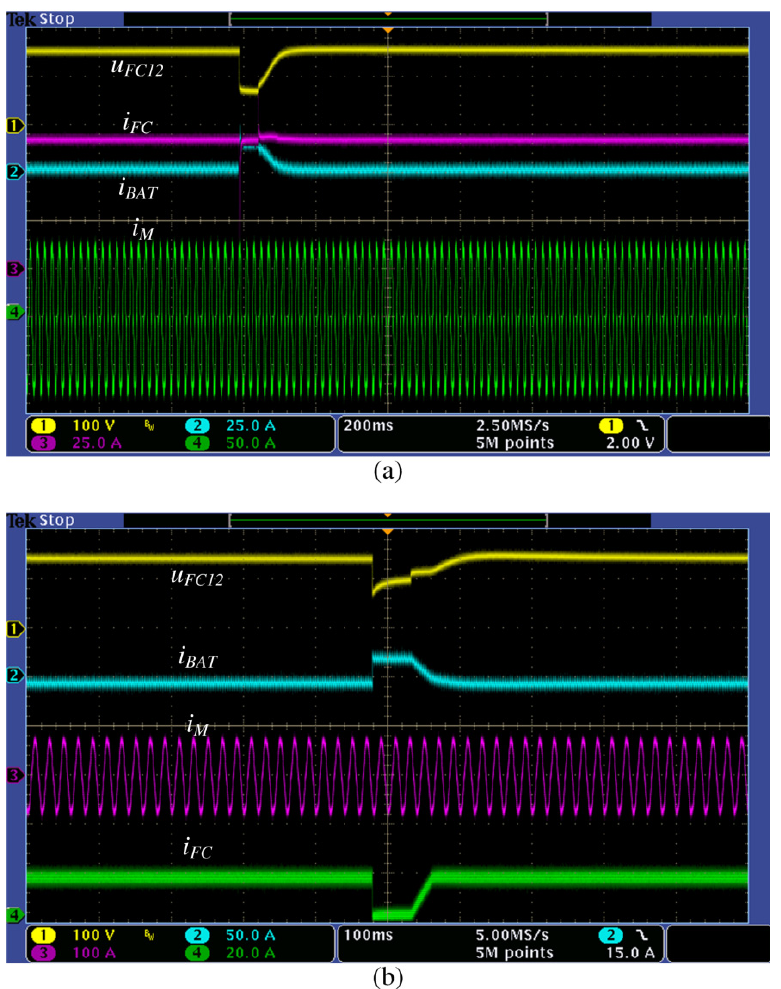
Figure 8. Possible behavior of the DC/DC converter during fuel cell short-circuit, ( a ) with loading and ( b ) with unloading, u FC12 –fuel cell total voltage, i FC –fuel cell current, i BAT –battery current, ( b ) with unloading, u FC12 -fuel cell total voltage, i FC -fuel cell current, i BAT -battery current, i M -motor i M –motor phase current. phase